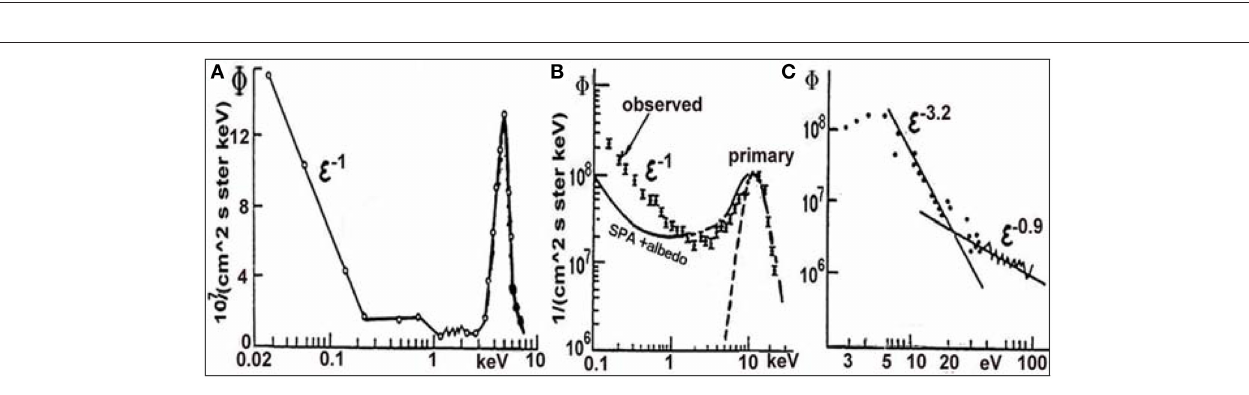
FIGURE 13 | Differential number fluxes over auroral arcs with the ‘bump-in-the tail’ distribution of primary electrons and flat power-law spectra of secondary electrons. Dots and circles show the observed fluxes, while dashed and solid lines show (B) a Gaussian approximation and (C) power-law trends. Adapted from (A) Arnoldy et al. (1974) . (B) Bryant et al. (1978), and (C) Feldman and Doering (1975). Reprinted by permission from the American Geophysical